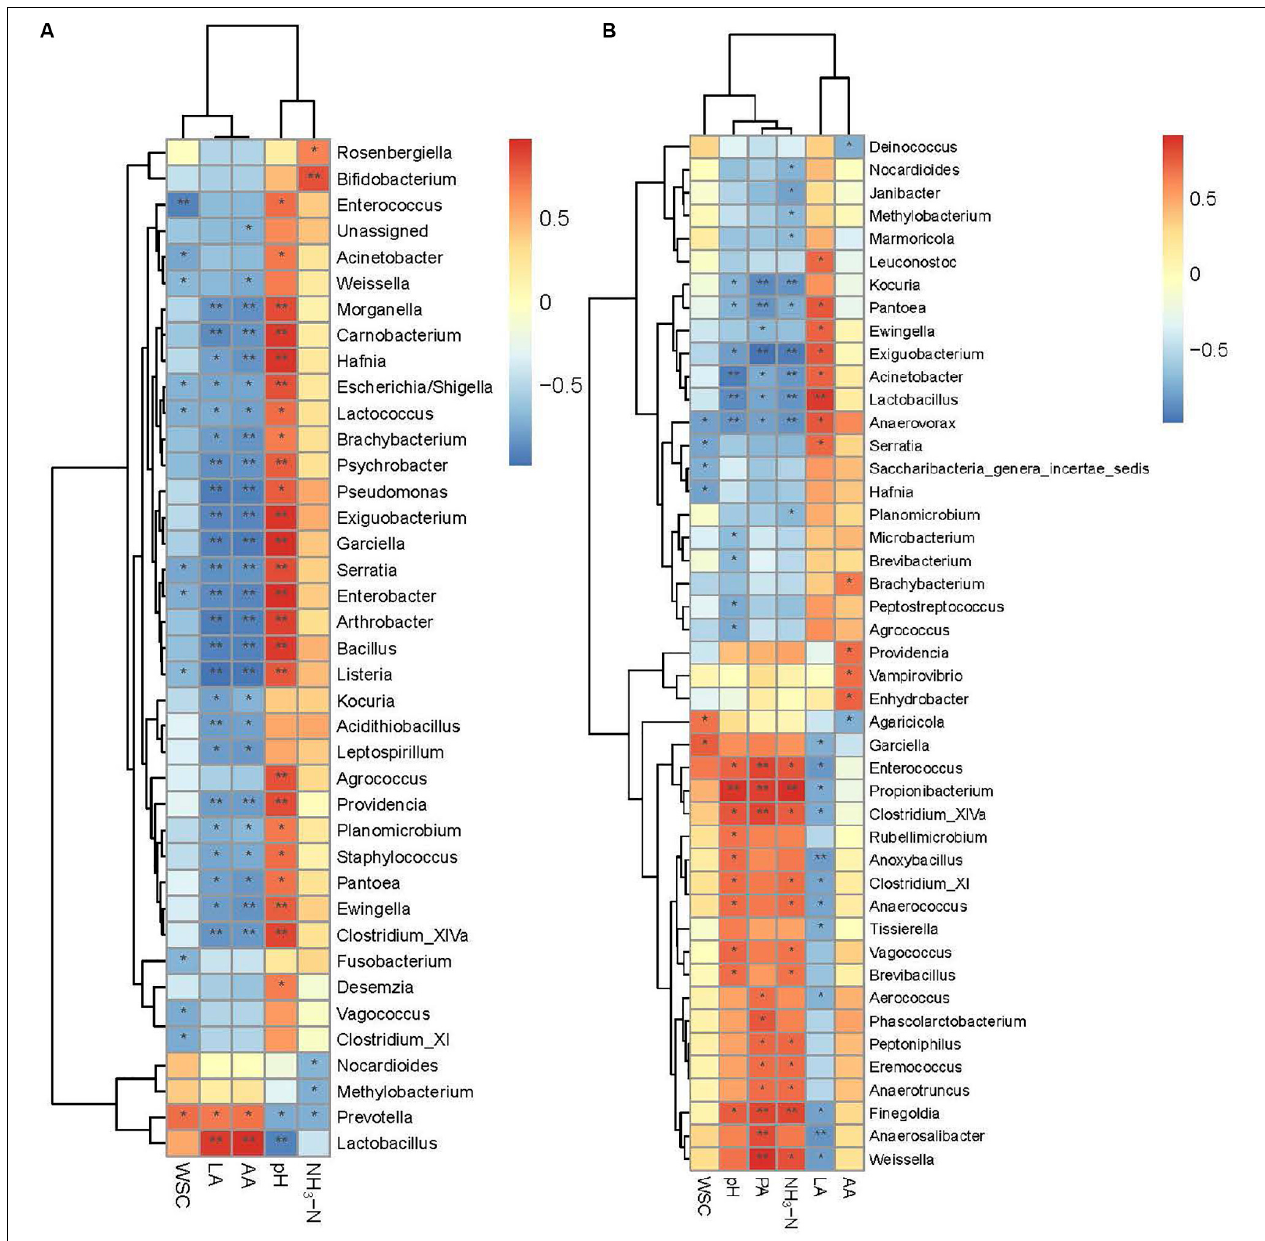
FIGURE 5 | Spearman correlation heatmap of abundance of bacterial genera and fermentation properties in alfalfa ensiled for 30 days (A) and 90 days (B) . LA, lactic acid; AA, acetic acid; LA/AA, lactic acid/acetic acid; PA, propionic acid; NH 3 -N, ammoniacal nitrogen; WSC, water soluble carbohydrate. * P < 0.05; ** P < 0.01.